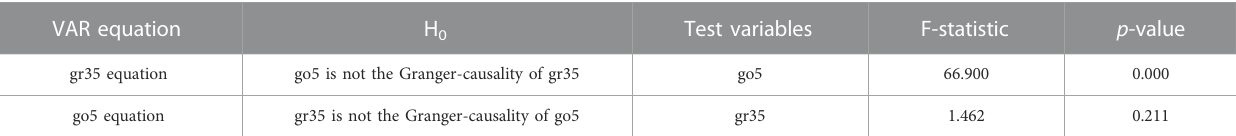
TABLE 4 Results of the gr35 and go5 Granger causality tests. VAR equation